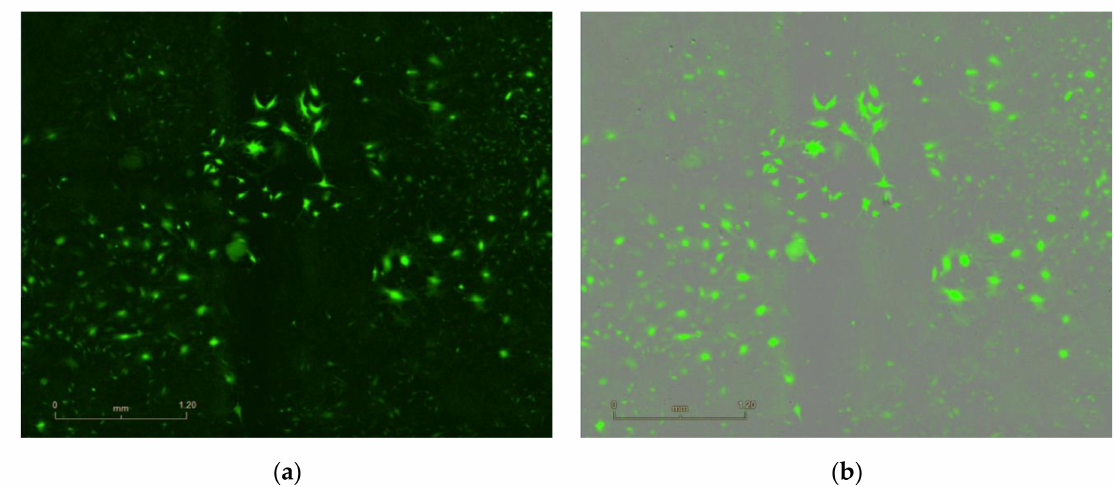
Figure 12. Uninteresting cells eliminate with tips and scraper. Use cell scraper to eliminate the cells at distant location from the marked clone. After that, eliminate the cells that closely surround the marked clone and on the edge of the well care- fully by using the pipette tips. ( a ) Cell elimination by using tips in 96-well plate well. ( b ) Cell elimination by using cell scraper in 6-well plate well. ( c ) Cell elimination by using tips in 6-well plate well. Figure 2. eGFP lentivirus infected N2C cells at seven days post infection. ( a ) Expression of eGFP in infected cells detected by fluorescence with Incucyte ® S3. ( b ) Overlap of fluorescence image with bright field image. Scale bars represent 1.2 mm. Figure 13. Imaging of the marked clones after elimination. ( a ) Image from Figure 11a after elimina- tion and two days incubation, Scale bar = 3.6 mm. ( b ) Image from Figure 11b after elimination and two days incubation. Scale bar = 1.8 mm.